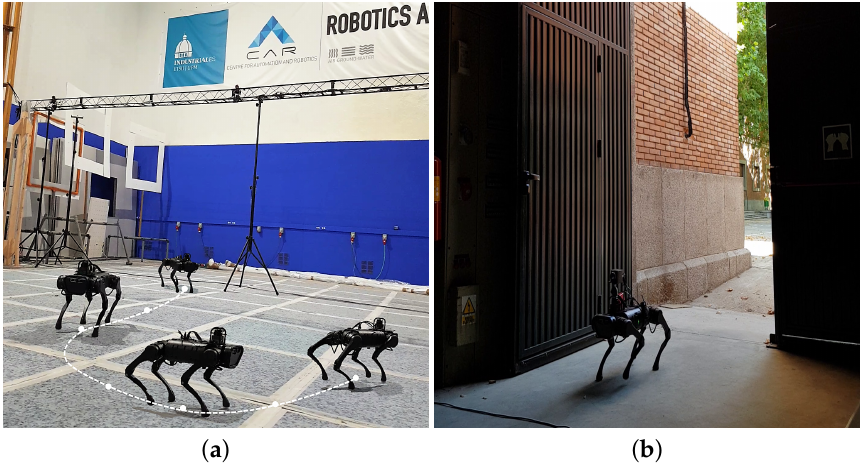
Figure 5. Robot Unitree in different scenarios. ( a ) Robot in indoors (good light conditions). ( b ) Robot in outdoors (bad light conditions). Source: